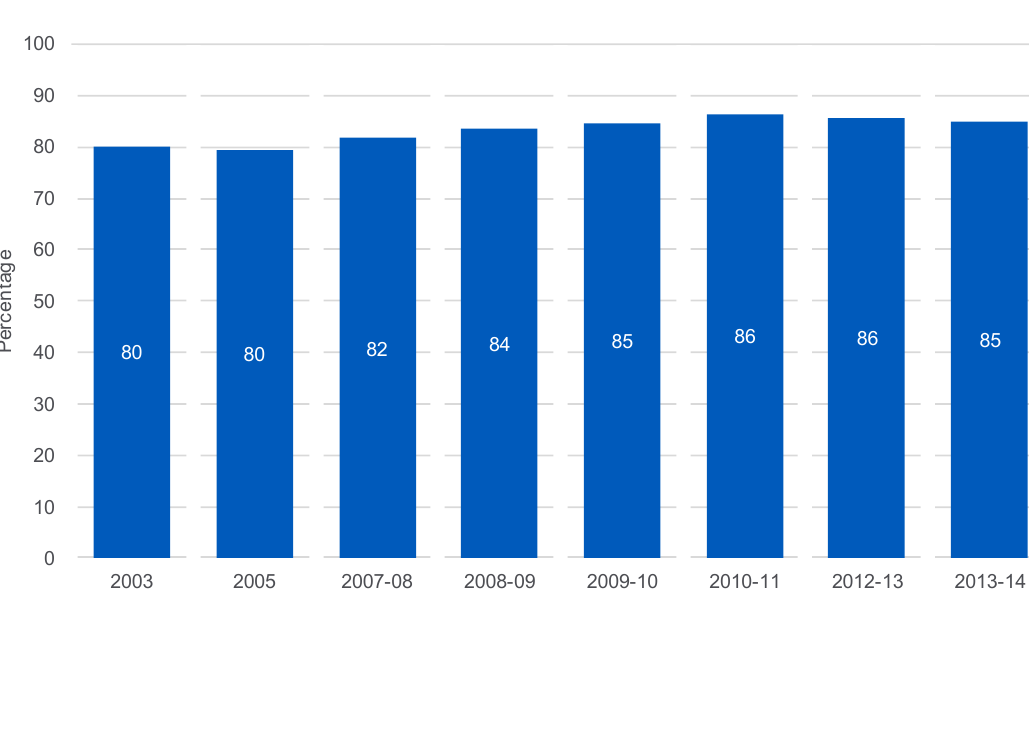
- Table 13: Community cohesion by sex, age, ethnicity and region, 2003 to 2013-14